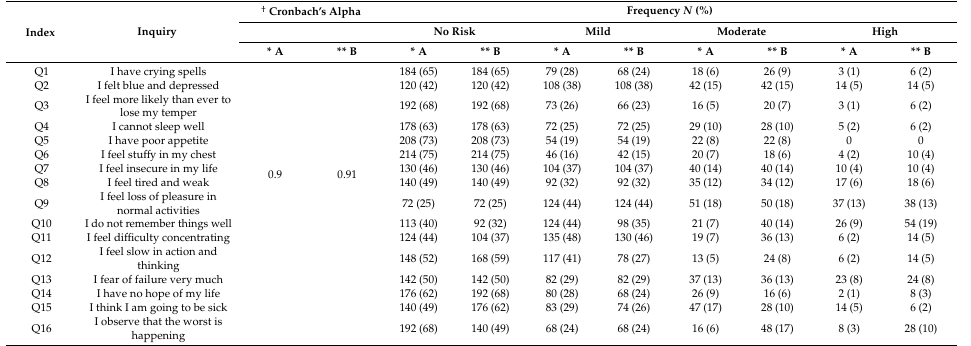
Table 1. Reliability Cronbach’s alpha coe ffi cients and frequency for each symptom of the self-rated measure